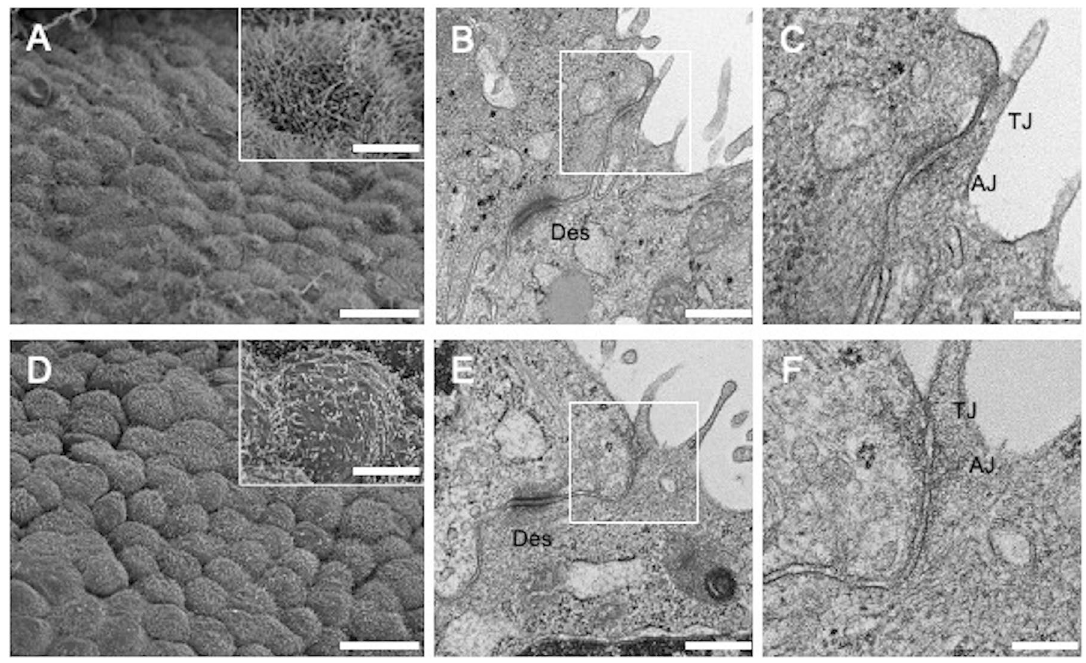
Figure 1. Electron microscopic photographs of visceral pleura from PSP and BHDS patients. ( A – C ) Show PSP and Figures ( D – F ) show BHDS (n = 3 for both PSP and BHDS). ( A , D ) are SEM images. ( B , C , E , F ) Are TEM images of cell–cell junctions. The insets within ( A , D ) are magnified views of PMCs. ( C , F ) Are the magnified views of the areas indicated by white rectangles within ( B , E ), respectively. Scale bars represent 20 μm ( A , D